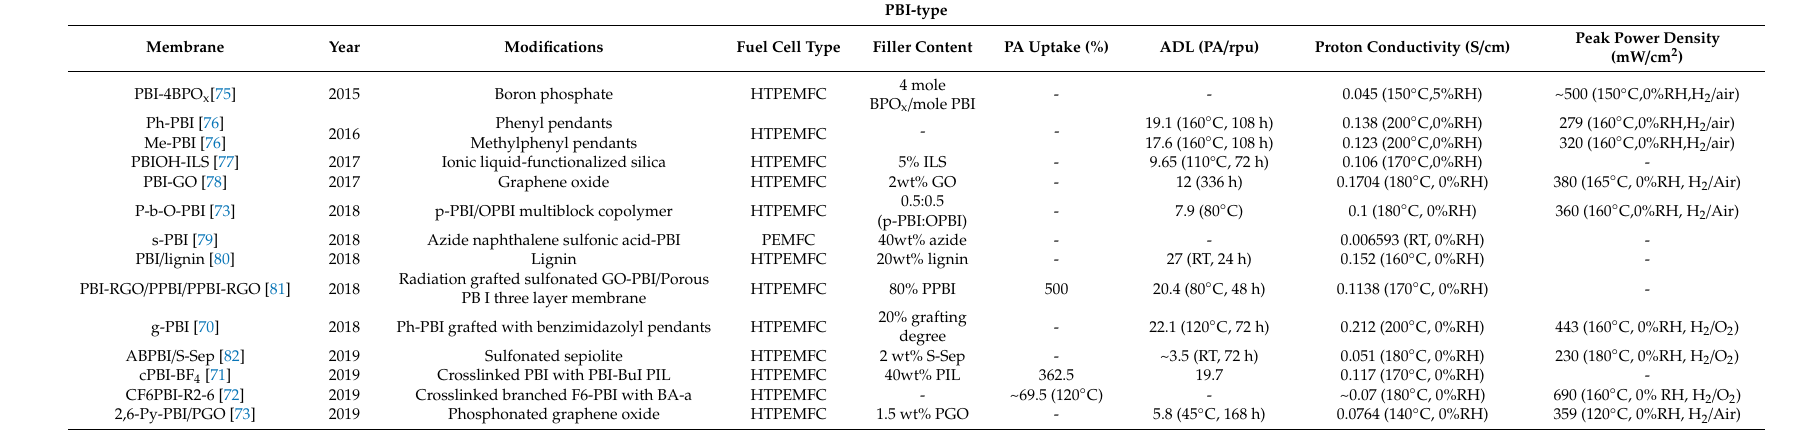
Table 6. Uptake, acid doping level (ADL), and electrochemical properties of PBI-type PEMs.